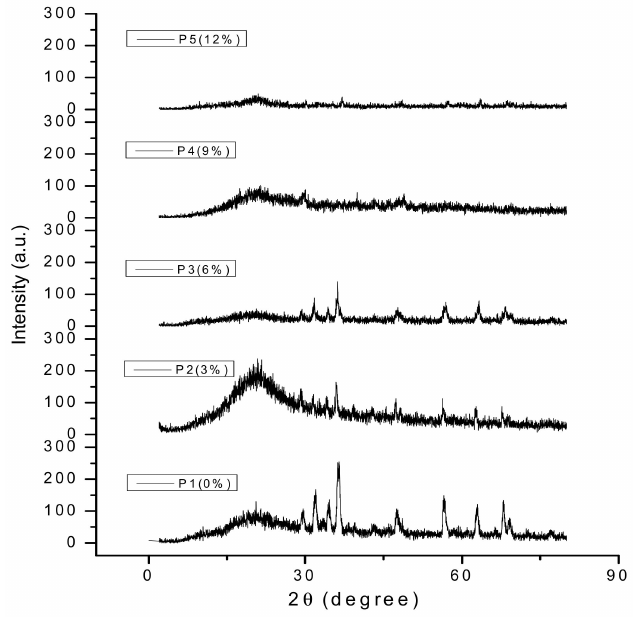
Figure 9. XRD spectra of coatings with the di ff erent wt. %